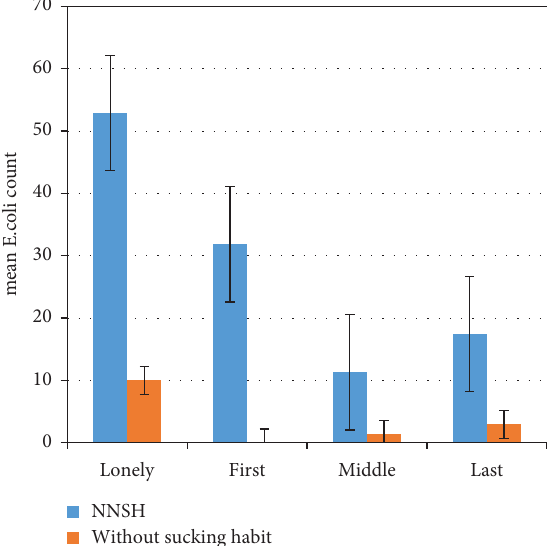
Figure 3: Mean E. coli count between the two groups according to the rank of the